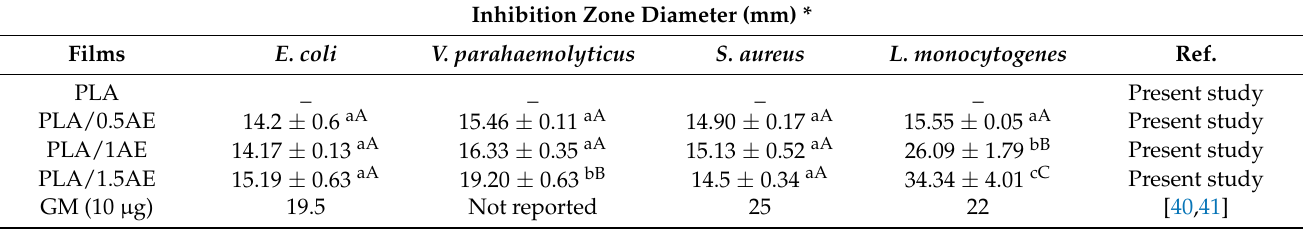
Table 4. Antibacterial evaluation of different poly lactic acid (PLA) films containing anise essential oil against four bacterial pathogens by disk diffusion method at 37 ◦